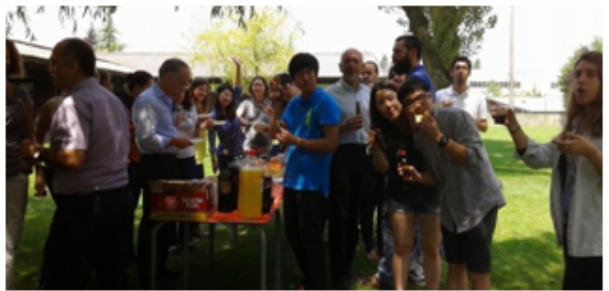
Figure 5. E4SD: Farewell picnic